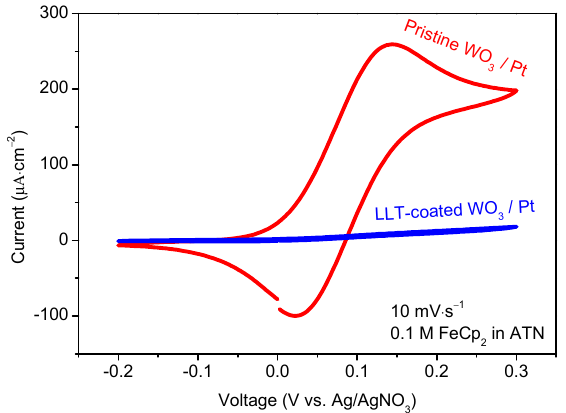
Figure 4. CV showing ferrocene reduction for 10 deposition cycles W-precursor deposition on a planar Pt substrate, annealed at 600 °C for 1 h in static air (red) and LLT-coated WO 3 (prepared under the same conditions) annealed at 500 °C for 1 h in static air (blue). The samples were measured at 10 mV·s − 1 . The third cycles are shown.